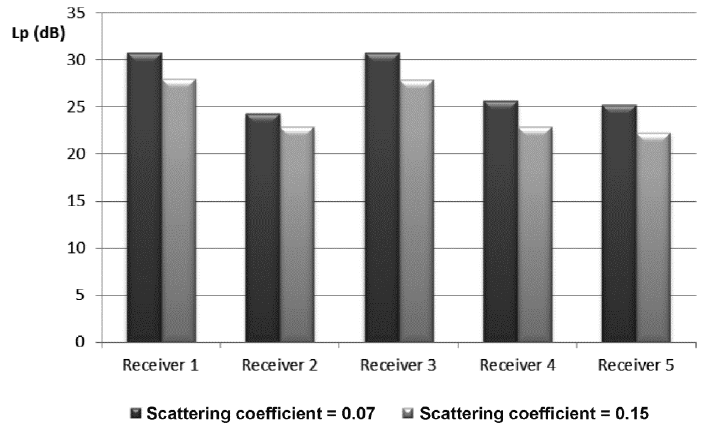
Figure 9. Comparison of the total sound pressure levels with lower (0.07) and higher (0.15) scattering coe ffi cients for the five receivers considered at the Llumeres location.